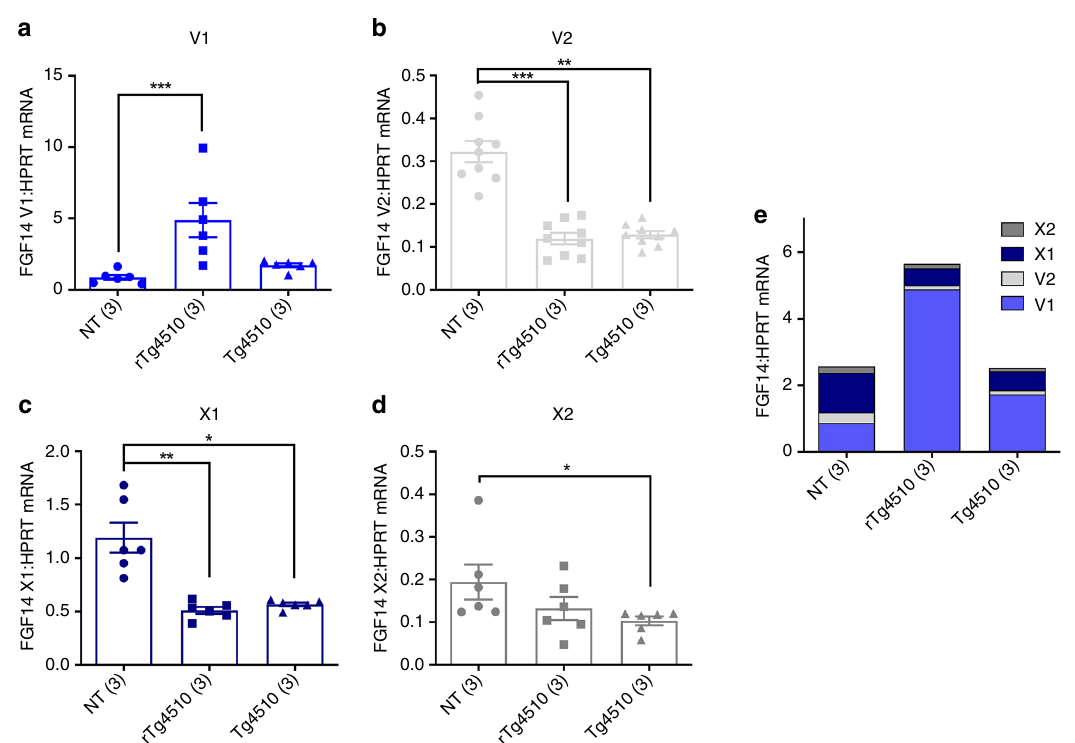
Fig. 4 Dysregulation of Fgf14 mRNA splice variants in rTg4510 and Tg4510 mice. Expression levels in the rostral one-third of dissected forebrain- hemispheres of Fgf14 variants V1 ( a ), V2 ( b ), X1 ( c ), and X2 ( d ) in nontransgenic (NT), rTg4510, and Tg4510 mice ( n ’ s in parentheses). Expression levels of each variant were determined by qRT-PCR relative to housekeeping gene Hprt . All samples were run in duplicate and data points from both experiments are shown. Kruskal – Wallis tests were performed for V1 ( H = 13.2, d f = 2, p < 0.0001), V2 ( H = 17.5, d f = 2, p < 0.0002), X1 ( H = 12.3, d f = 2, p = 0.0001), and X2 ( H = 6.9, d f = 2, p = 0.026) groups, followed by Dunn ’ s multiple comparisons tests. All data were normalized to a positive calibrator, and are expressed as the group mean ± standard error. e Compiled group mean data for all variants. * p ≤ 0.05, ** p ≤ 0.01, *** p ≤ 0.001. Source data are provided as